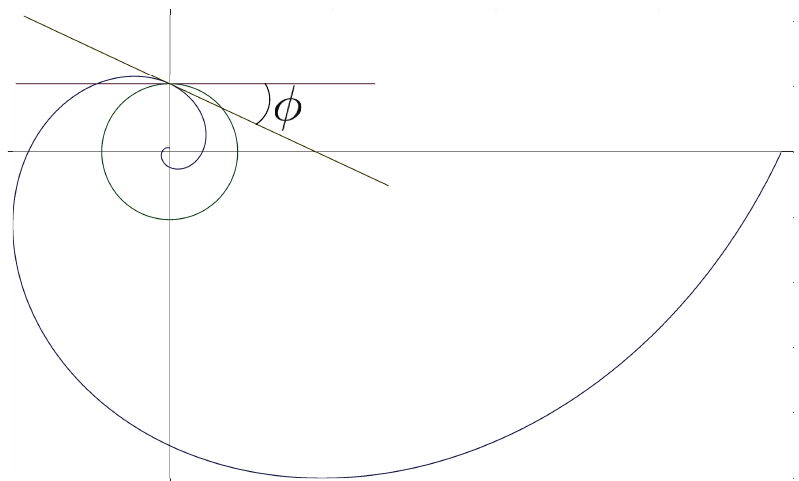
Figure 1. This figure illustrates the geometric definition of the pitch angle, φ , of a logarithmic spiral. Specifically, φ is the angle between the line drawn tangent to the circle and the other line drawn tangent to the logarithmic spiral, as depicted. In this case, φ = − 25 ◦ , where the negative sign indicates, by our convention, that the spiral winds outward in a counterclockwise